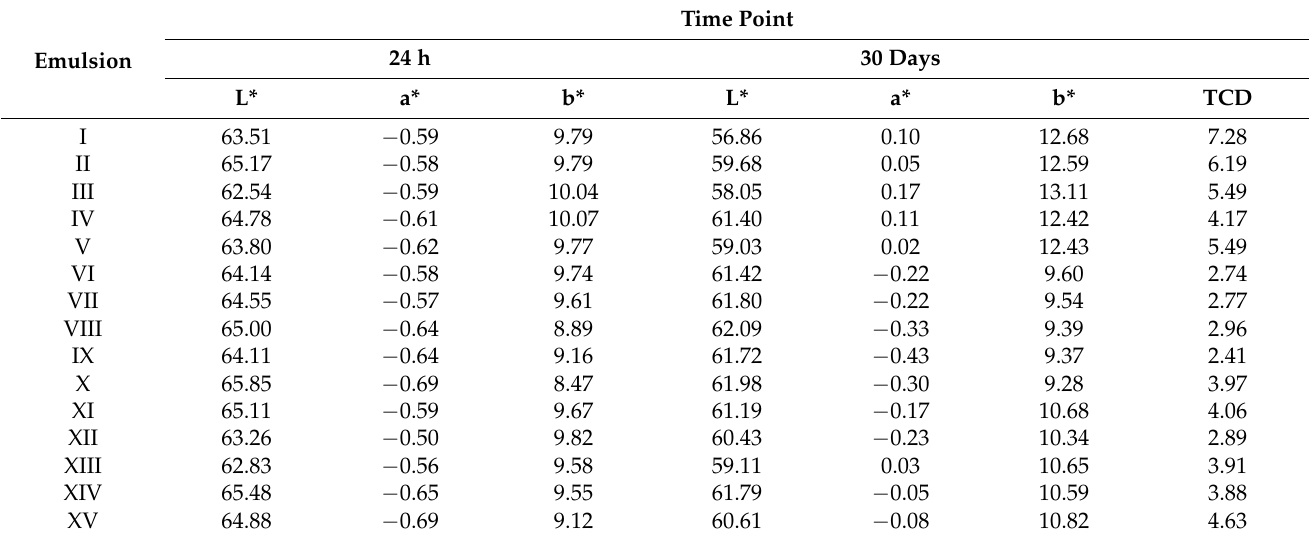
Table 2. Results of colorimetric study of the emulsion after 24 h and 30 days from their